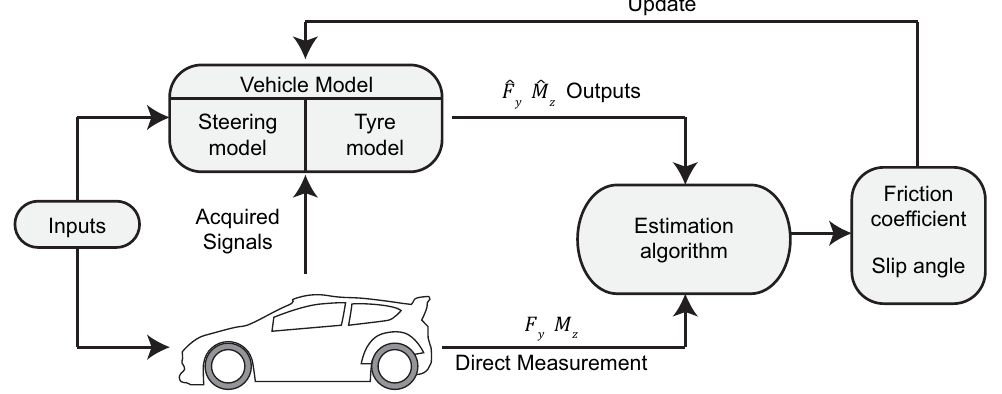
Figure 18. Estimation structure for medium excitation levels described in Ahn et al. [107,118]. Figure adapted by the authors from